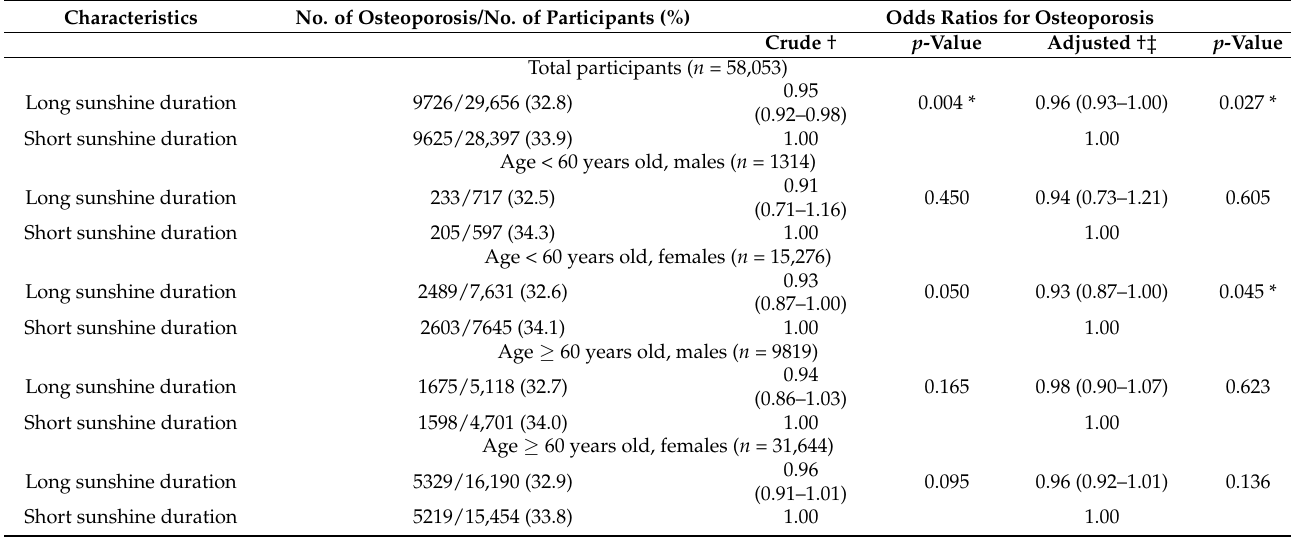
Table 3. Crude and Adjusted Odds Ratios (95% Confidence Intervals) of Long Sunshine Duration for Osteoporosis with Subgroup Analyses According to Age and